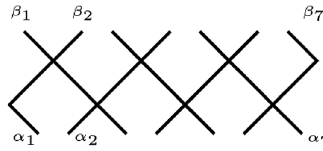
Figure 2 . Diagonal-to-diagonal transfer